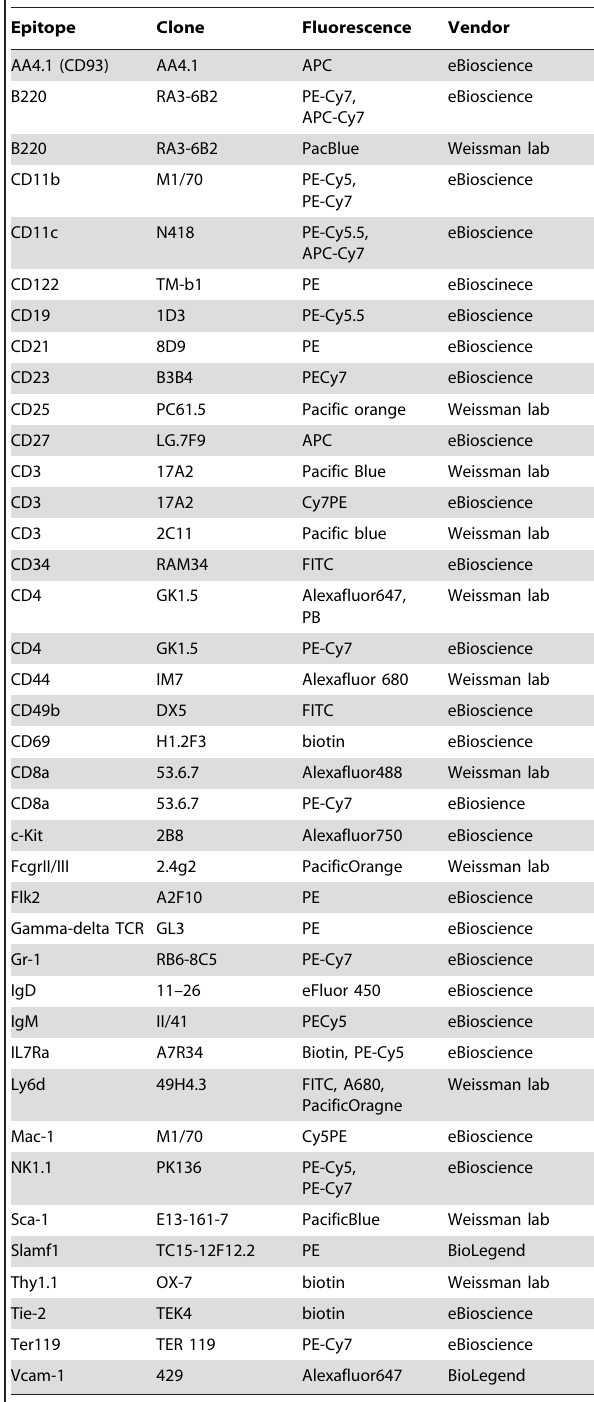
Table 5. Clone and Conjugation of Antibodies